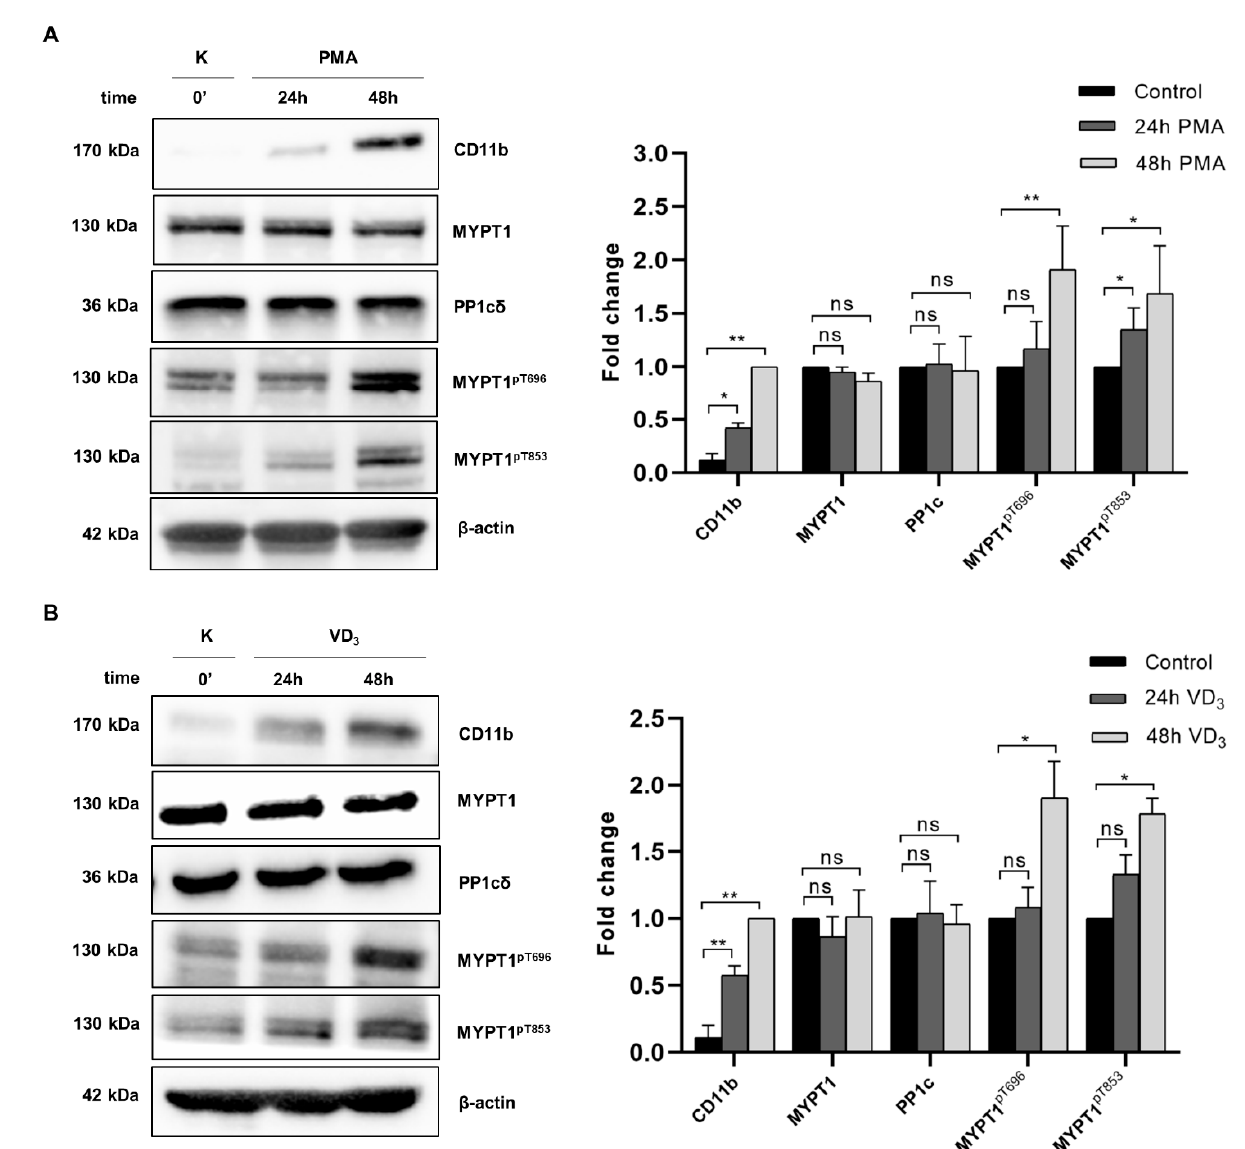
Figure 2. Changes in the expression and phosphorylation of myosin phosphatase subunits during PMA- and VD 3 -induced differentiation. THP-1 cells were stimulated with PMA ( A ) or VD 3 ( B ) to induce differentiation, then cell lysates were